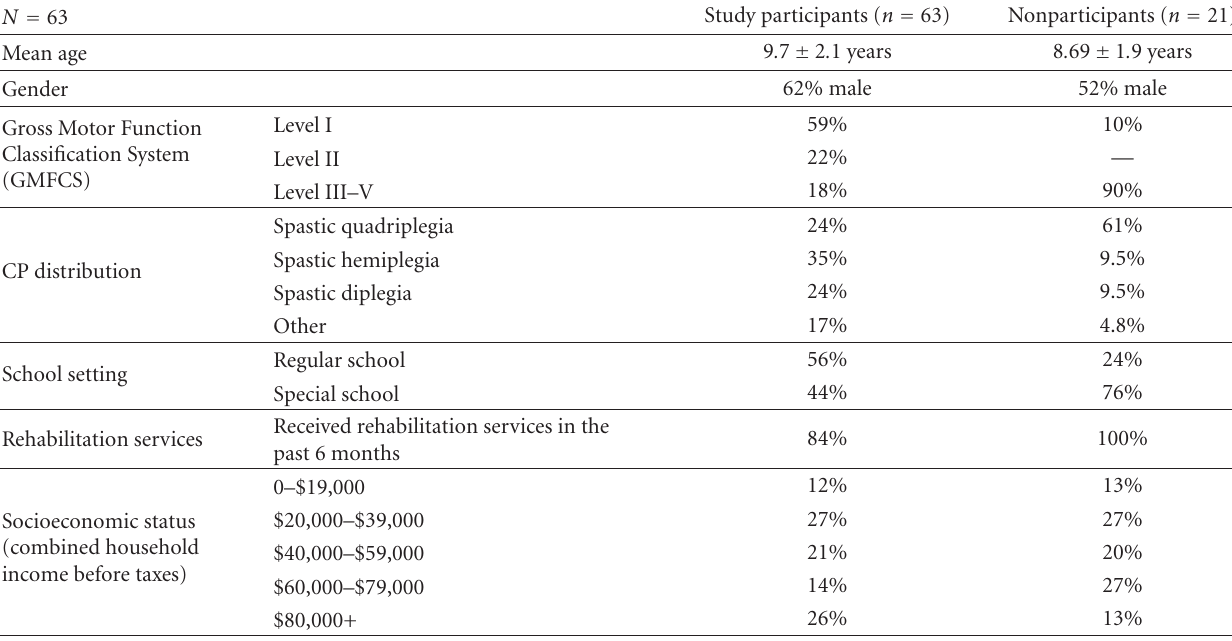
Table 1: Characteristics of